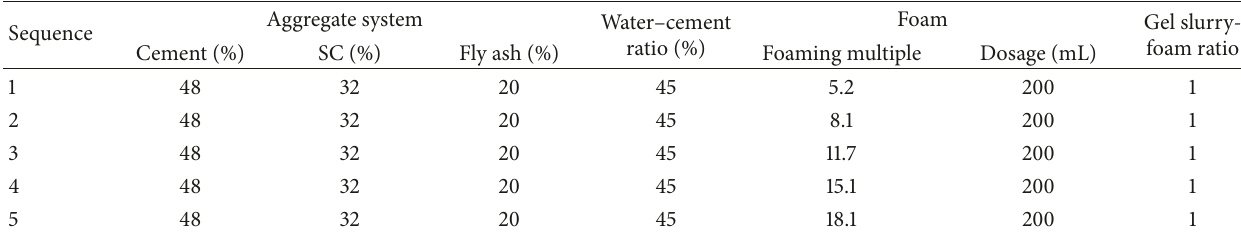
Table 10: Effect of expansion ratio on the material.